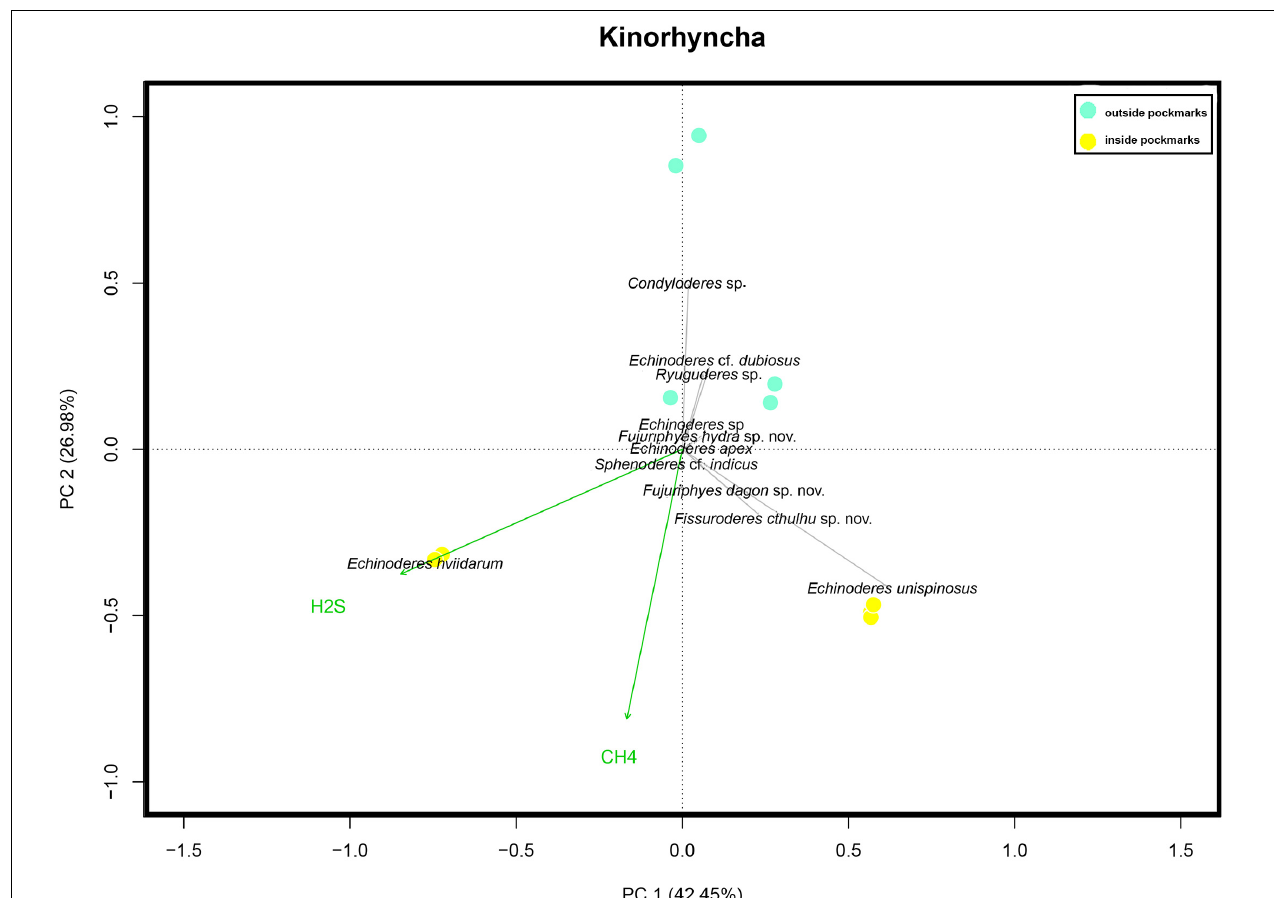
FIGURE 13 | Principal component analysis scaling two bi-plots based on Hellinger-transformed data on kinorhynch species composition considering the four study sites: two sites inside pockmarks (yellow) and two sites outside pockmarks (blue). Passive ( post hoc ) explanations of axis were conducted using environmental variables (CH 4 , methane; and H 2 S, hydrogen sulfide